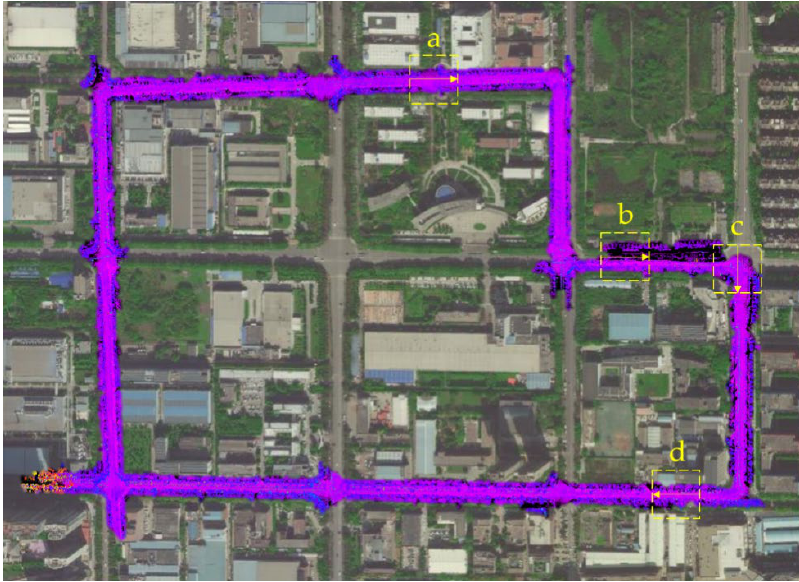
onto the real vehicle, and the driver drove the vehicle through the designated road section.